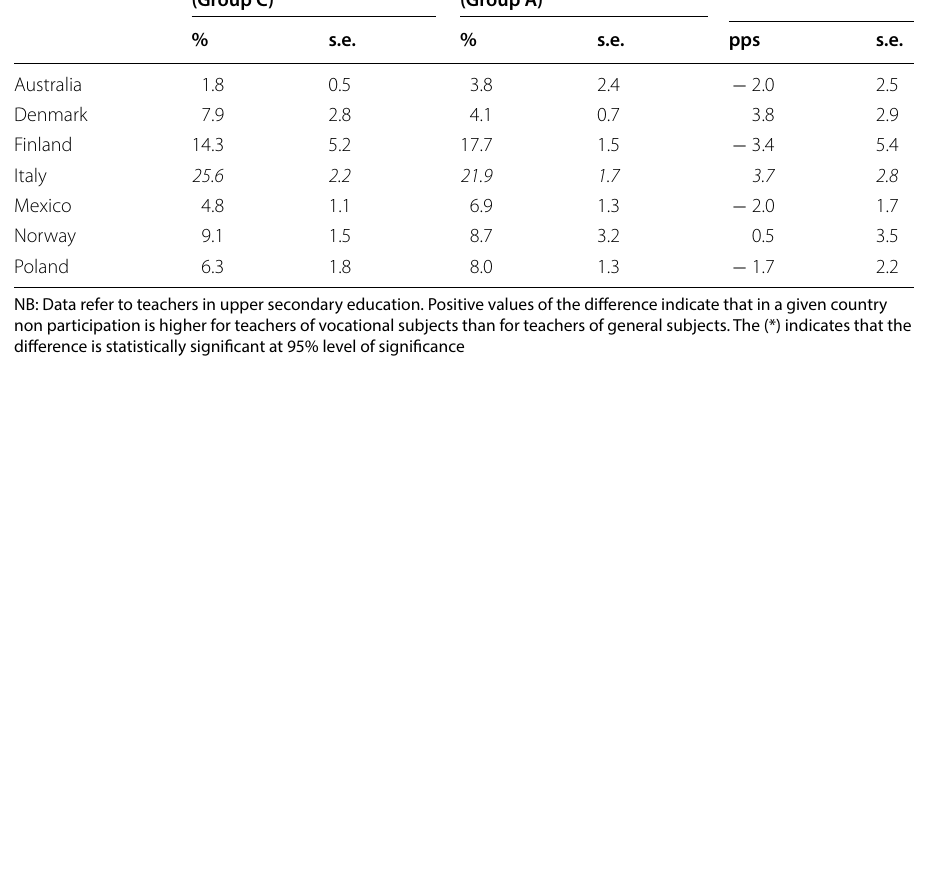
Table 5 Non participation in teachers’ professional development activities: differences between Group C and Group A of teachers, in percentage points (pps) and standard error of the difference (s.e.), 2013 (Source: Author’s calculations based on OECD, TALIS 2013)